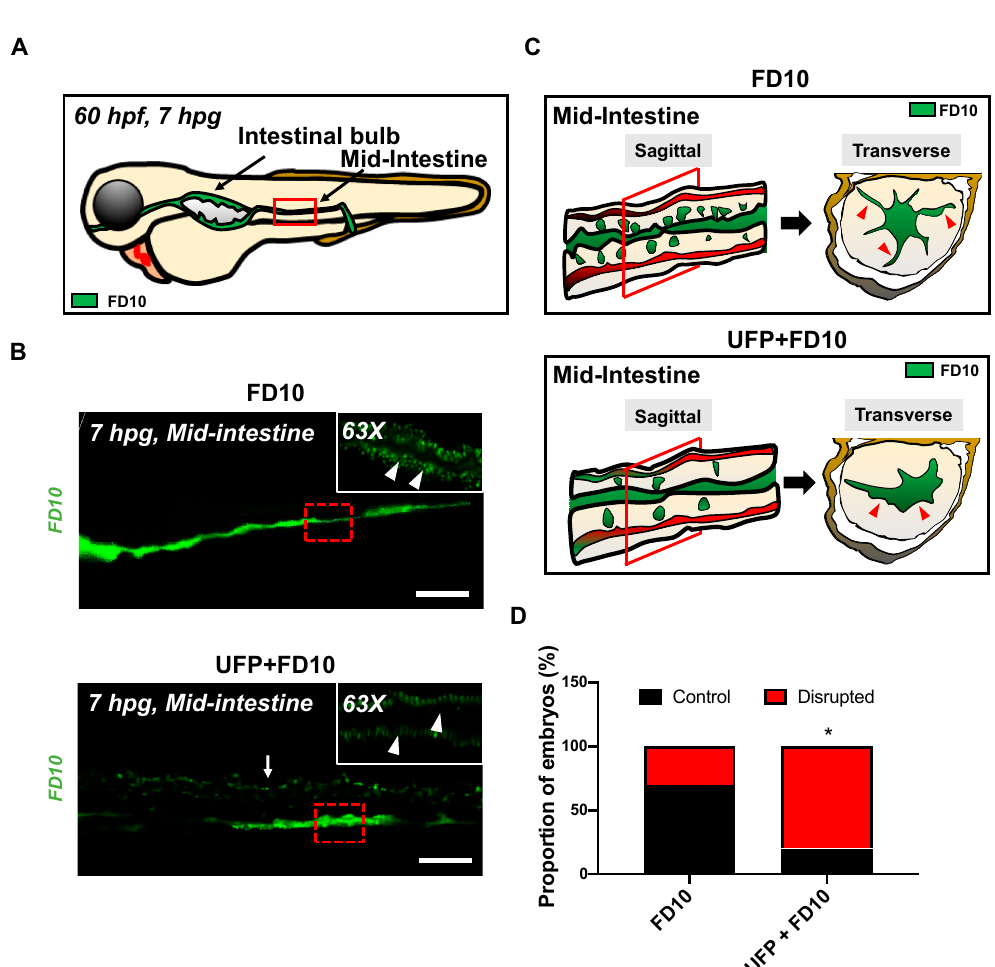
Figure 2. Acute UFP exposure disrupts maturation of embryonic GI tract. ( A ) Schematic representation of the embryonic GI tract at 7 hpg. The density of FD10 fluorescence in the mid-intestine was assessed to evaluate maturation of the GI tract (Red box). ( B ) Representative images of UFP-disrupted GI tract (white dashed box). Compared to FD10-gavaged controls, co-gavaging UFP, as denoted with endoluminal FD10 fluorescence (white arrow), altered morphology and systemically reduced the density of FD10 fluorescence in the mid-intestine (white arrowheads, n = 5 per group). Scale bar: 20 µ m. ( C ) Schematic representations of sagittal and transverse views of the mid-intestine with and without UFP gavage. Acute UFP exposure in developing GI system retards maturation (red arrowheads). ( D ) Percentage of embryos exhibiting reduced FD10 density in the mid intestine ( * p < 0.05 vs. FD10, n = 10 per group).